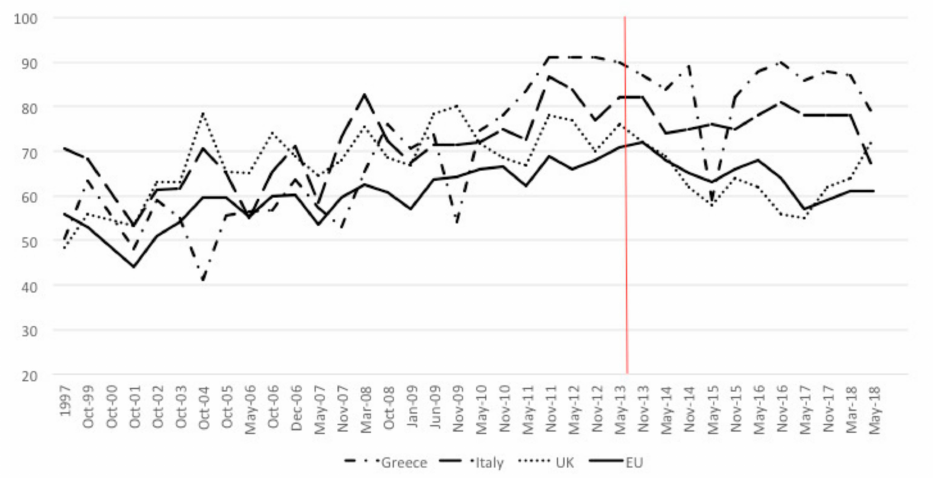
Figure 1. Percentage of citizens that ‘tend not to trust’ their national government.